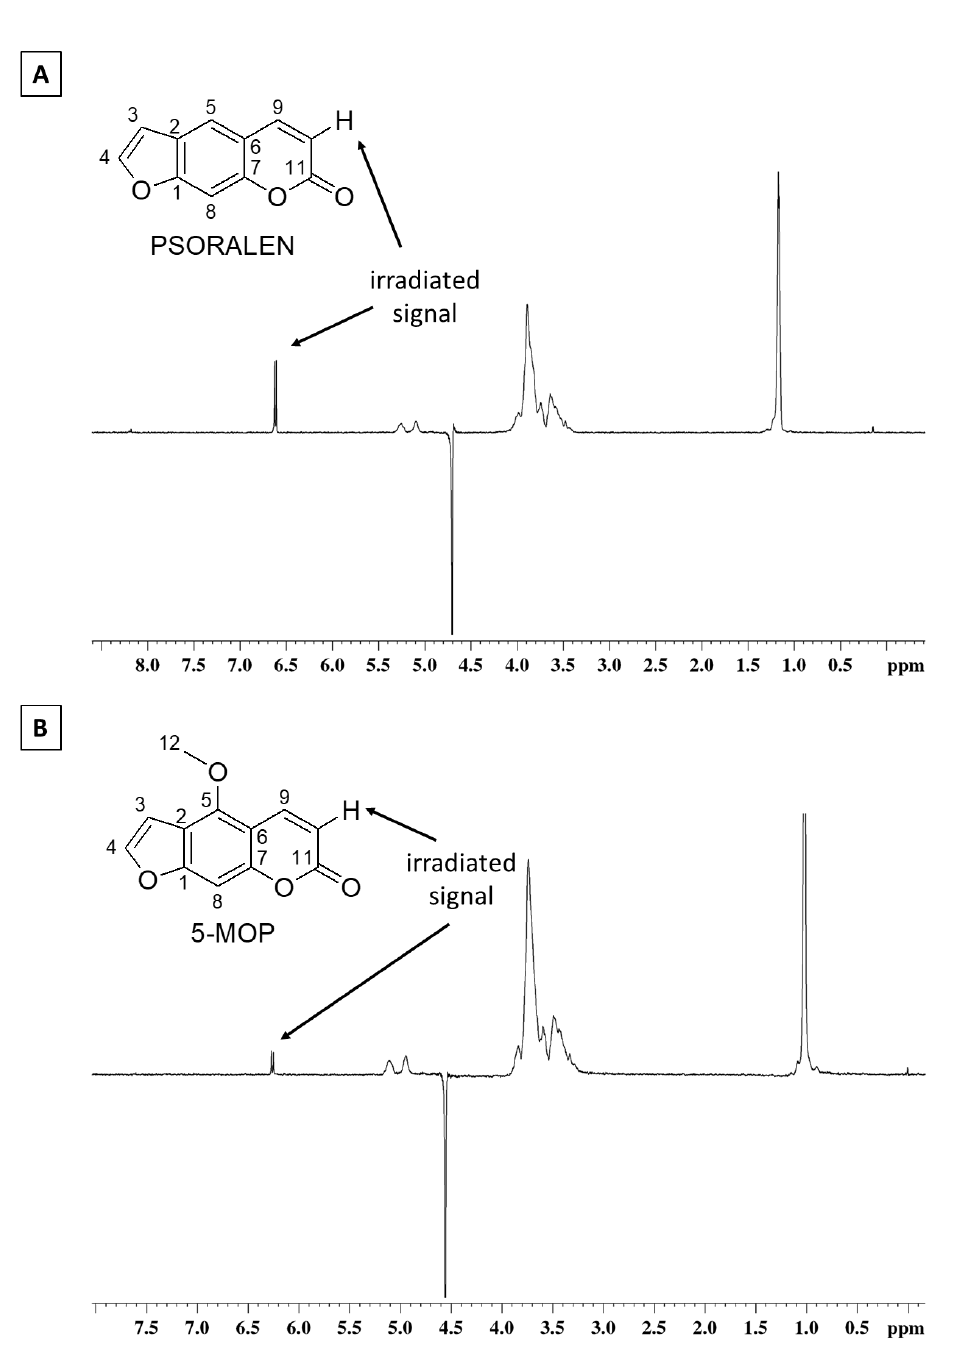
Figure 3. NOESY experiments for PSO ( A ) and 5-MOP ( B ) solutions. H-10 signals were irradiated, and polarization transfers to HP- β -CD were observed.